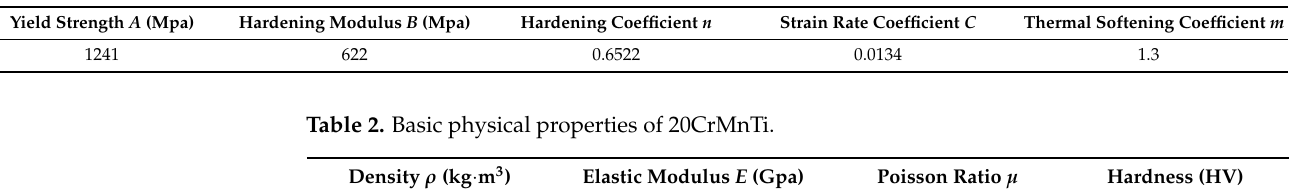
Table 1. Johnson-Cook model of 20CrMnTi.